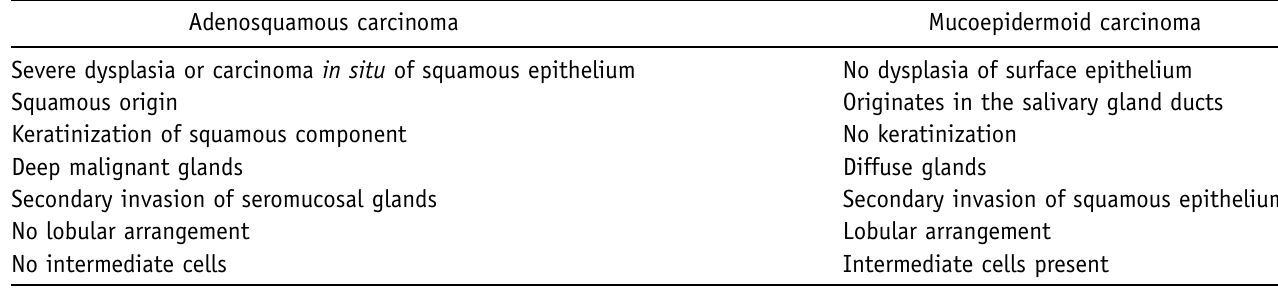
Table I. Histopathological comparison of ASC and MEC.